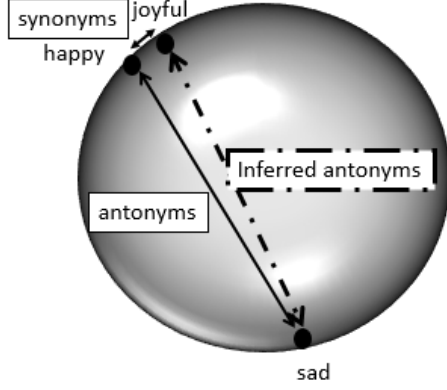
Figure 1. Semi-supervised